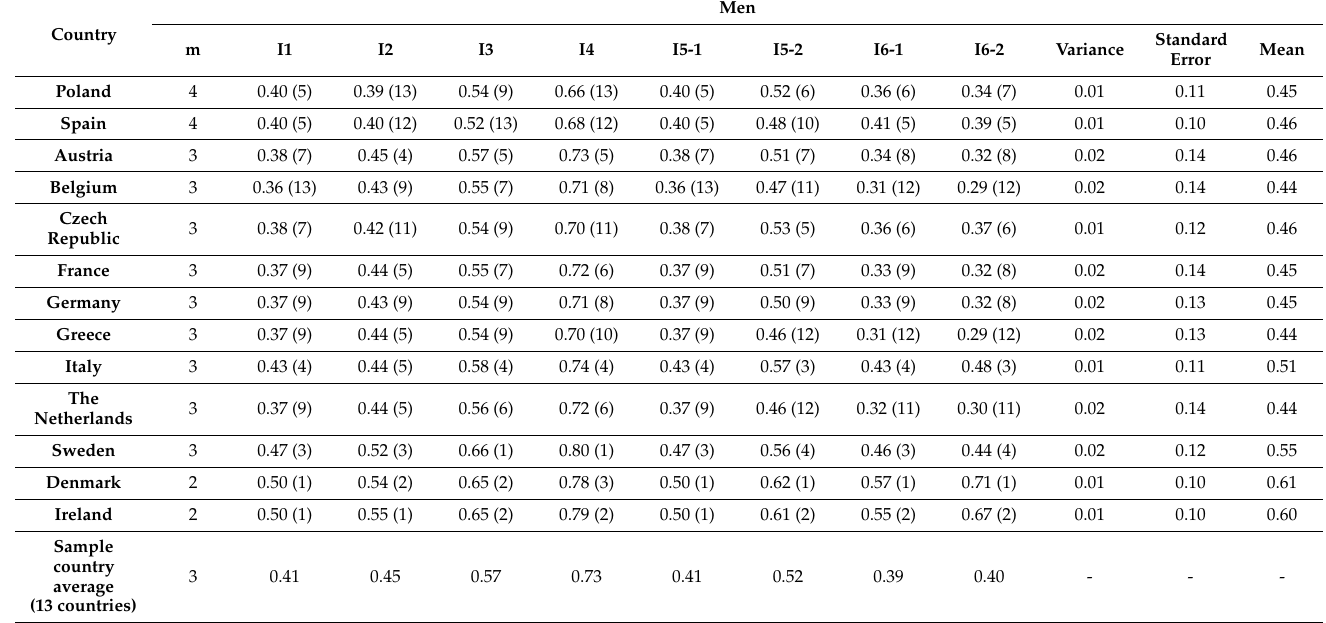
Table 5. Inequality indicators in self-perceived health in Wave 2 (2006) for men.